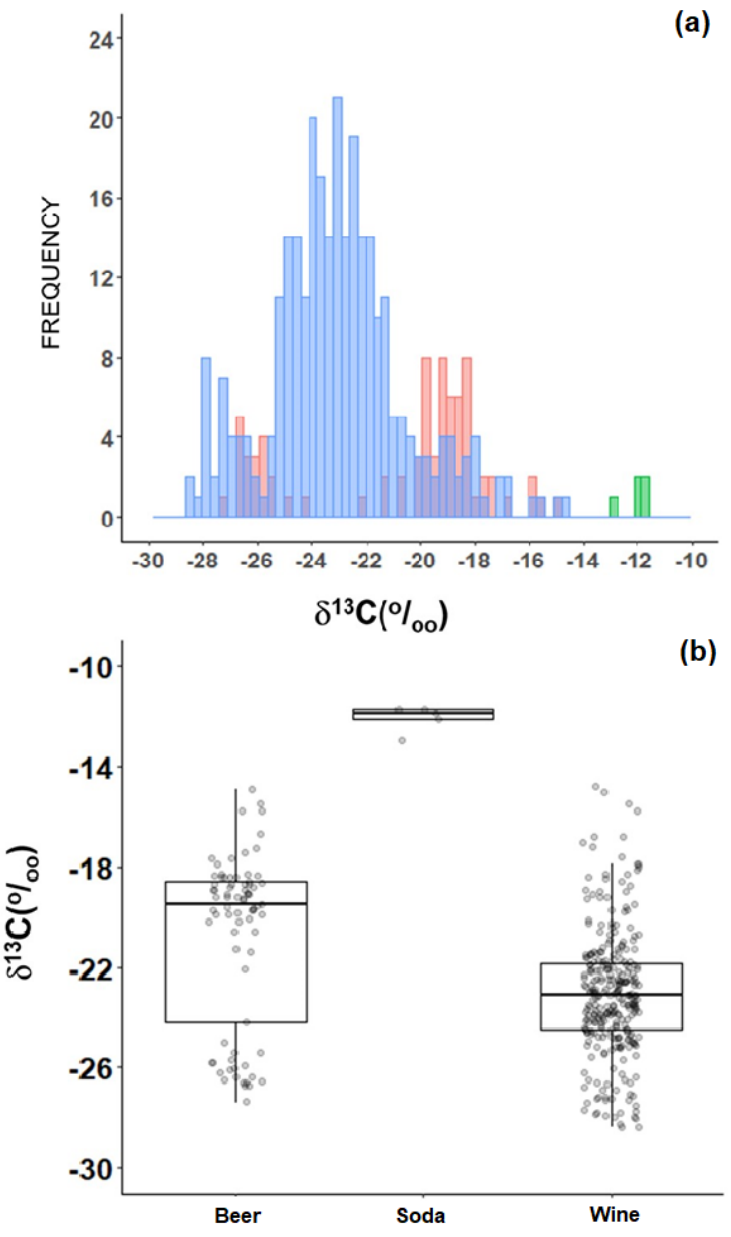
Figure 5. Frequency histogram ( a ) box-whisker ( b ) of δ 13 C of alcoholic beverages in Brazil. The blue bars represent wine samples, the green bars represent cachaça samples, and the red bars represent beer samples.